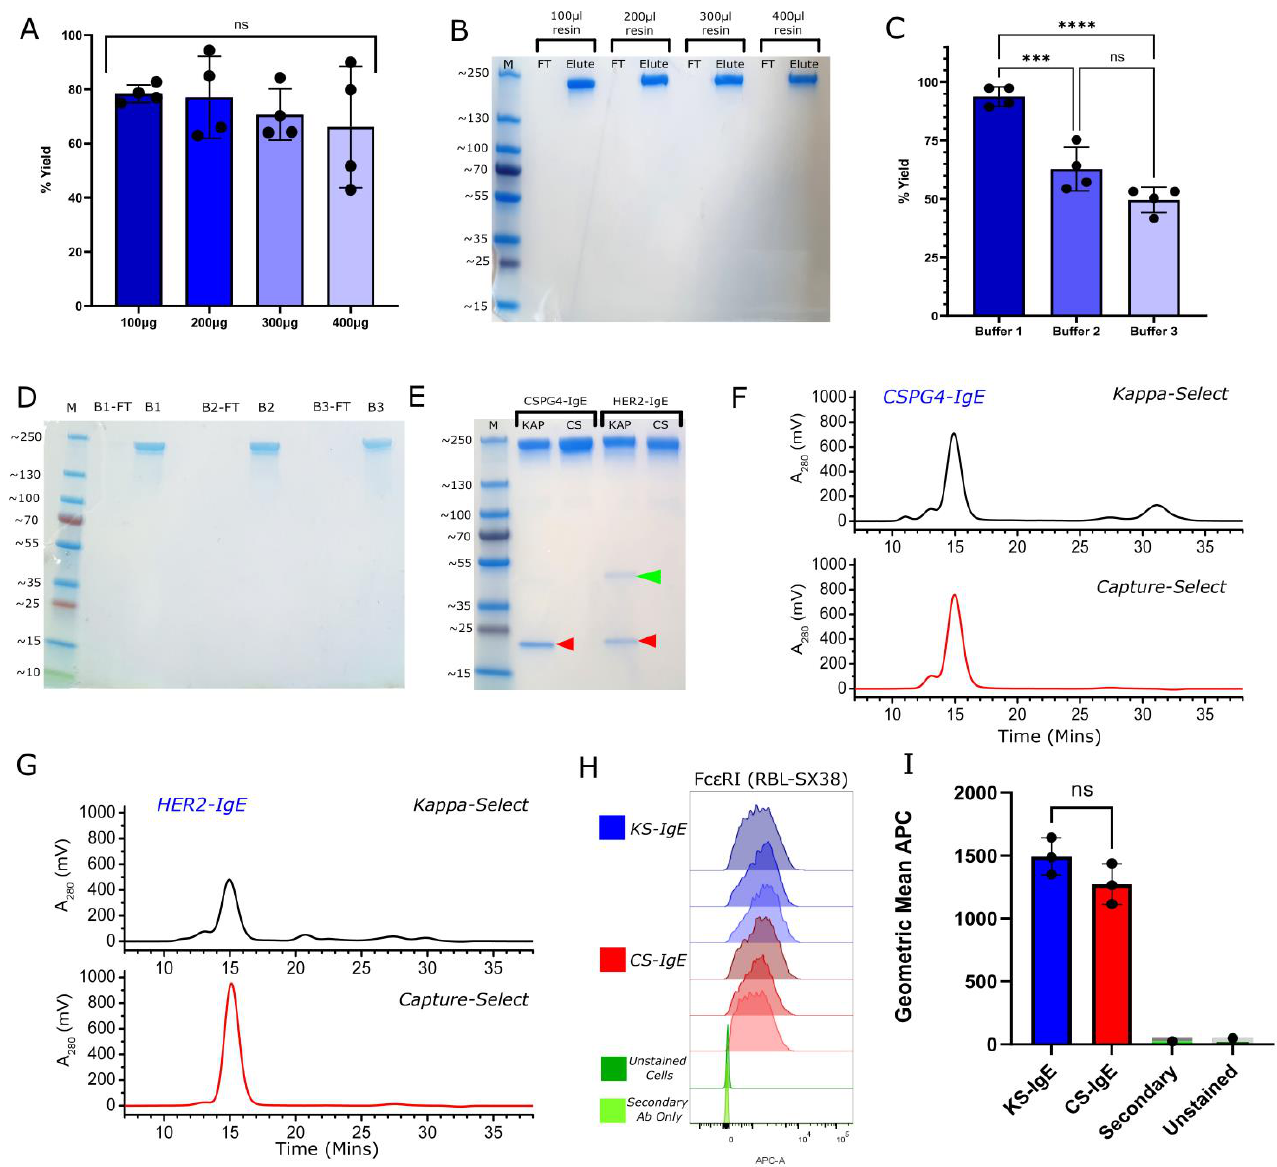
Figure 1. Optimization of IgE Purification using IgE class-specific affinity chromatography. ( A ). Quantitation of the % yield CSPG4-IgE antibody recovered using varying volumes of resin slurry from a set IgE volume of 100 μ g per purification, N = 4, error bars = SD (Standard Deviation); ( B ) . InstantBlue-stained SDS-PAGE of IgE purified using variable resin volumes against a set concentration of IgE under non-reducing conditions, representative experiment from A (FT: flow through; Elute: column elute; M: molecular marker); ( C ) . Quantitation of the % yield of CSPG4-IgE recovered using different elution buffers from a set IgE volume of 100 μ g and a resin slurry volume of 200 μ L. Buffer 1 = 50 mM Sodium Citrate + 50 mM NaCl, pH 3.5; Buffer 2 = 0.1 M Glycine, pH 2.3; Buffer 3 = 20 mM Citric Acid, pH 3.0. N = 4, error bars = SD; *** p > 0.005 **** p > 0.001 ( D ). InstantBlue-stained SDS-PAGE of IgE purified using different elution buffers against a set concentration of IgE, shown under non-reducing conditions. B1: Buffer 1 = 50 mM Sodium Citrate + 50 mM NaCl, pH 3.5; B2: Buffer 2 = 0.1 M Glycine, pH 2.3; B3: Buffer 3 = 20 mM Citric Acid, pH 3.0. Representative independent experiment from C (B-FT: flowthrough; B: column elute; M: molecular marker); (E). InstantBlue-stained SDS-PAGE of IgE purified using light chain-specific (KappaSelect) or IgE class-specific (CaptureSelect™) affinity chromatography, for CSPG4 -specific IgE and HER2-specific IgE. M, molecular marker; KAP = KappaSelect- purified; CS = CaptureSelect™ -purified. Red arrows indicate free light chain; green arrows indicate additional impurities in KS-purified HER2-IgE; ( F ). SEC analysis of CSPG4-specific IgE purified via light chain (black) versus IgE class-specific (red) affinity